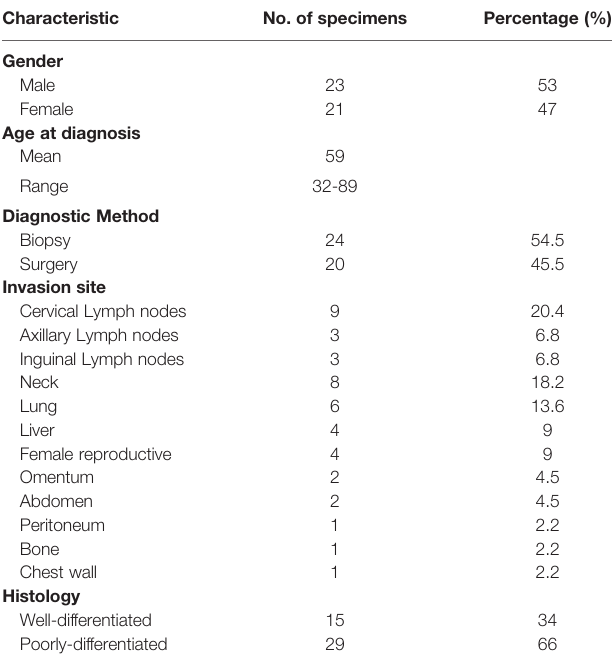
malignant tumors ( Figure 2 ).